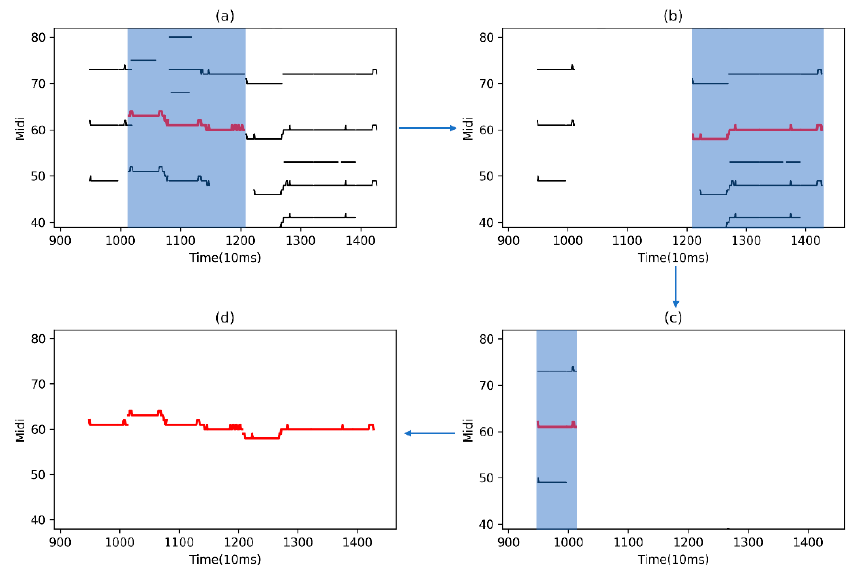
Figure 5. The process of melody contour filtering: ( a ) Searching the maximum energy contours on 𝛺(cid:3560) (cid:3435)𝛺(cid:3560) (cid:3038) , (cid:3038)(cid:2878)(cid:2869) (cid:3439) ; ( b ) searching contours on taining final